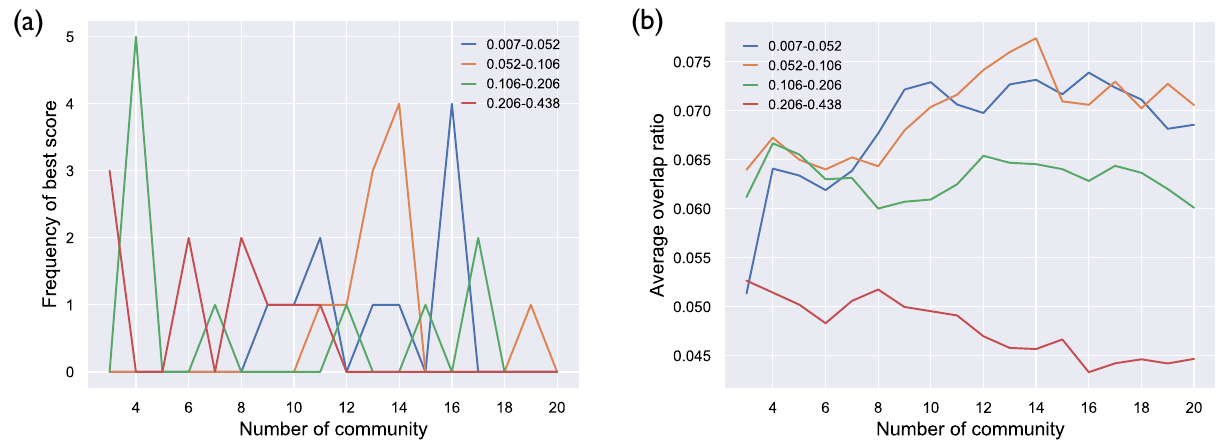
Figure 1. ( a ) The frequency of the best overlap score for each cluster number and each frequency band. ( b ) Averages of overlap scores across thresholds for each cluster number and each frequency